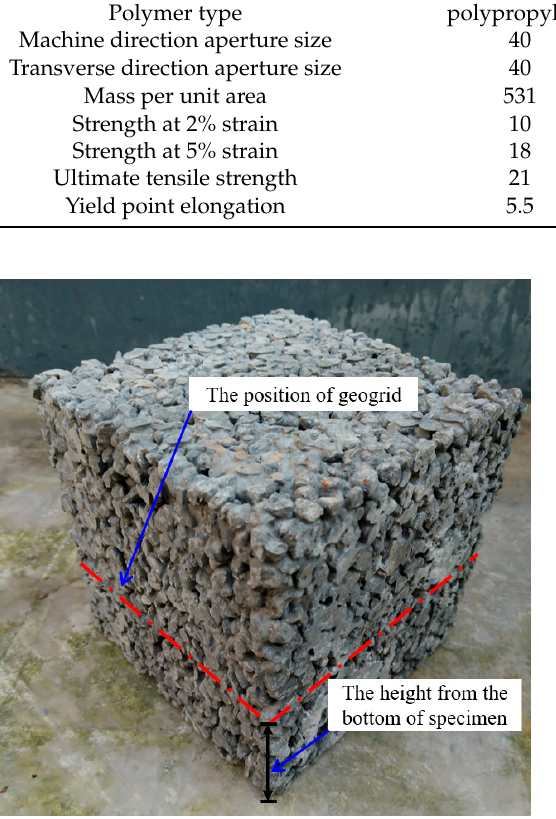
Figure 3. The position of geogrid in specimen.